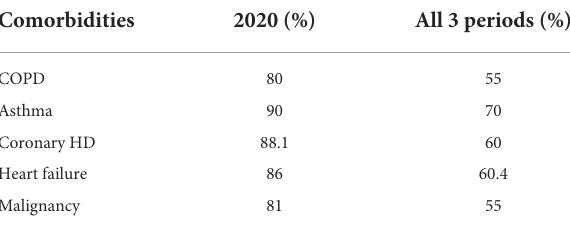
TABLE 3 Vaccination for seasonal influenza of T2D individuals with comorbidities .